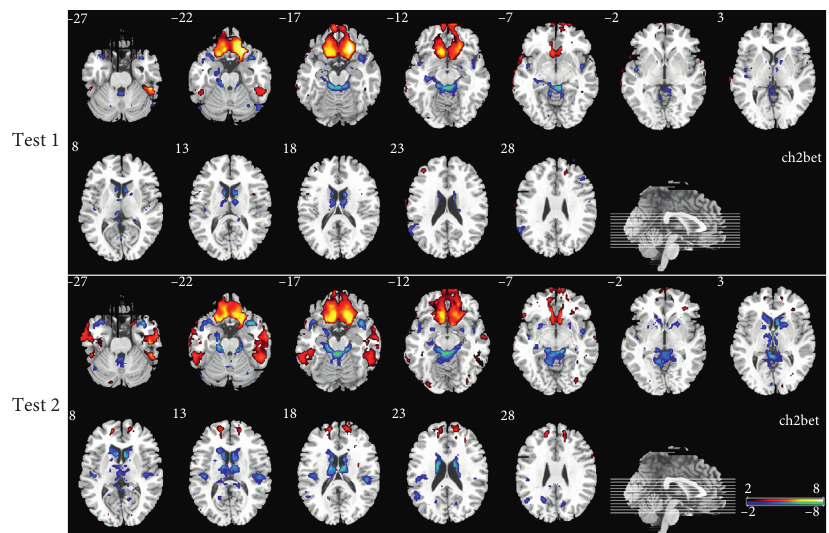
Figure 3: Difference results of FSST and FFT in Test1 and